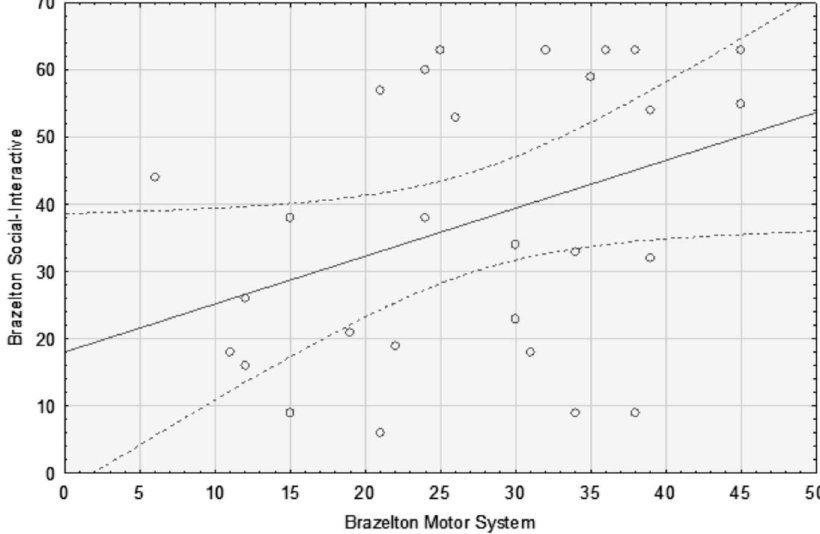
Figure 3. The Neonatal Behavioral Assessment Scale: “Motor System” vs. “Social Interactive”